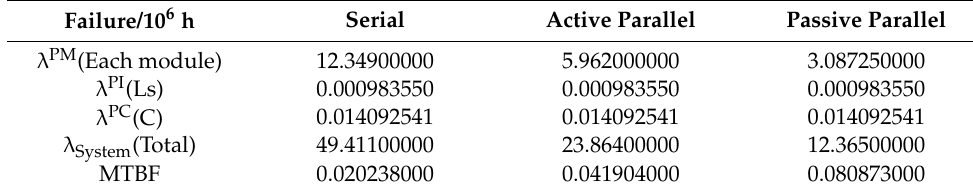
Table 5. Reliability of the different